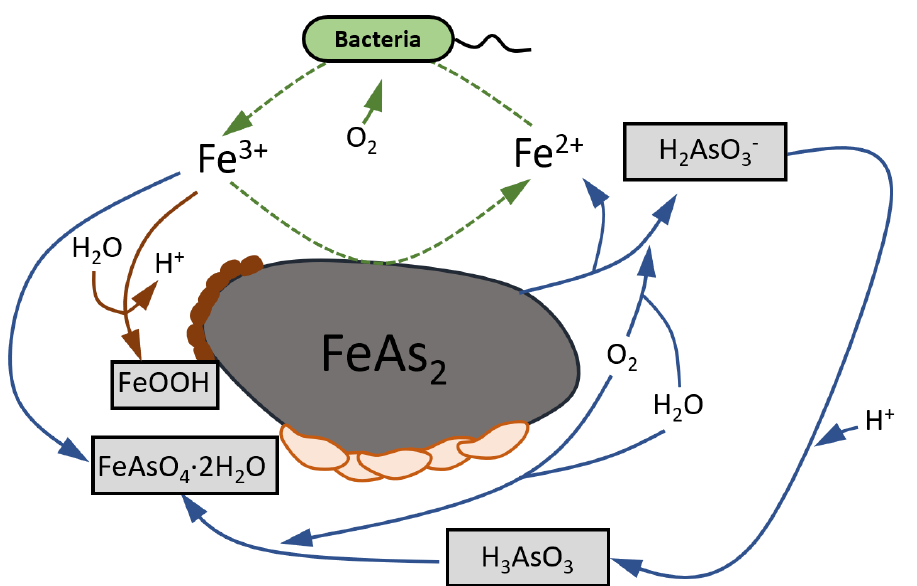
Figure 1. Conceptual scheme of oxidative dissolution of